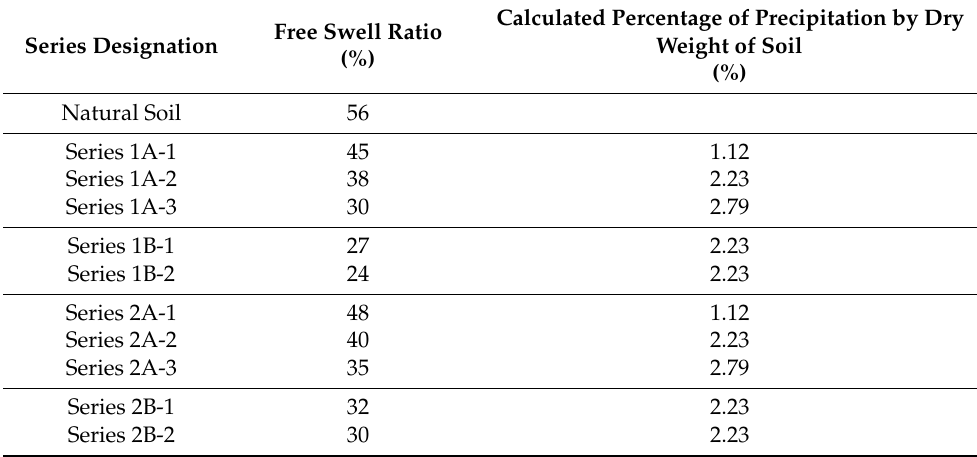
Table 5. The results of free swell